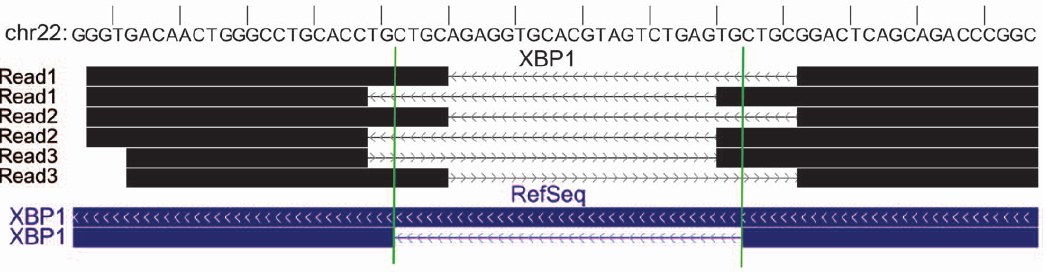
Figure 7. XBP1 non-canonical intron. HMMSplicer discovers the non-canonical XBP1 intron. HMMSplicer identifies three reads containing the non-canonical CA-AG splice site in XBP1 . Because the reads are fairly evenly split, both read-halves aligned to the genome. The edges identified by HMMSplicer are 2 and 4 bp off from the actual splice site because the sequence at the beginning of the intron repeats the sequence at the beginning of the subsequent exon. When identical junctions are collapsed, there are two junctions, one with a score of 1024 and one with a score of 1030, which puts them in the top 0.5% of the collapsed non-canonical junctions.